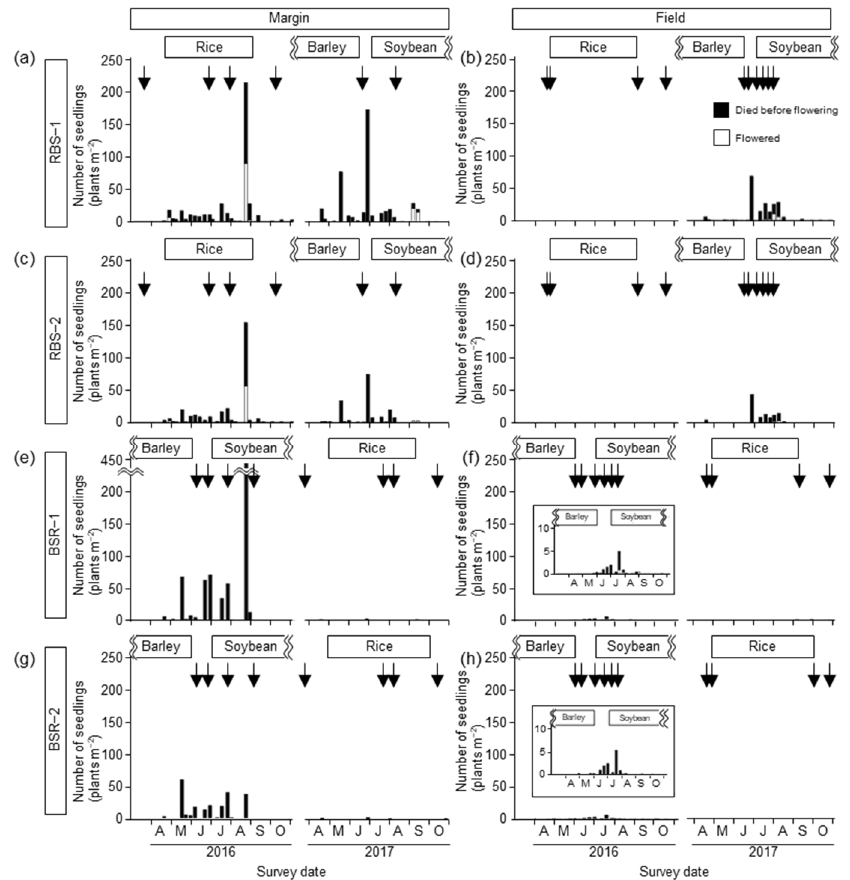
Figure 2. Number of seedlings of entireleaf morning glory at the time of each survey and the data of flowering success/failure of the seedlings. Field margin ( a ) and field ( b ) of RBS-1; field margin ( c ) and field ( d ) of RBS-2; field margin ( e ) and field ( f ) of BSR-1; field margin ( g ) and field ( h ) of BSR-2. The number of newly emerged seedlings at each survey is the sum of white and black areas (stacked bar chart). The white and black areas on the bars indicate the numbers of individuals with successful and failure of flowering (died before flowering); arrows indicate dates of weed management practices (including tillage); RBS-1, rice–barley–soybean-1; RBS-2, rice–barley–soybean-2; BSR-1, barley–soybean–rice-1; BSR-2, barley–soybean–rice-2. Values are presented as mean. The inset figures in panels ( f , h ) show an enlarged view of the results in 2016. The horizontal axis shows the survey months (April to October of each year).